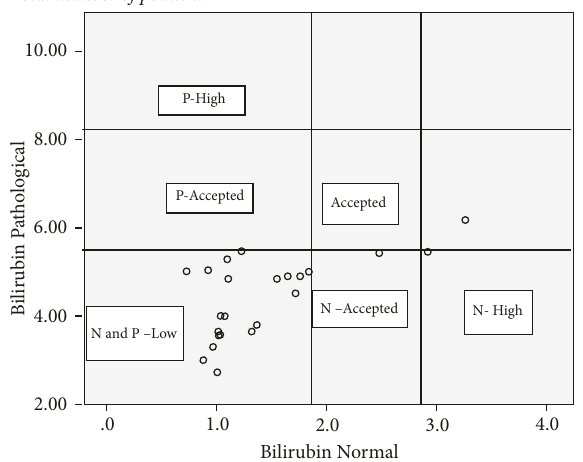
Figure 4: Plotof controlsample total bilirubinpathological P values versus control sample total bilirubin normal N values for the total of 23 reported points. P: pathological; N: